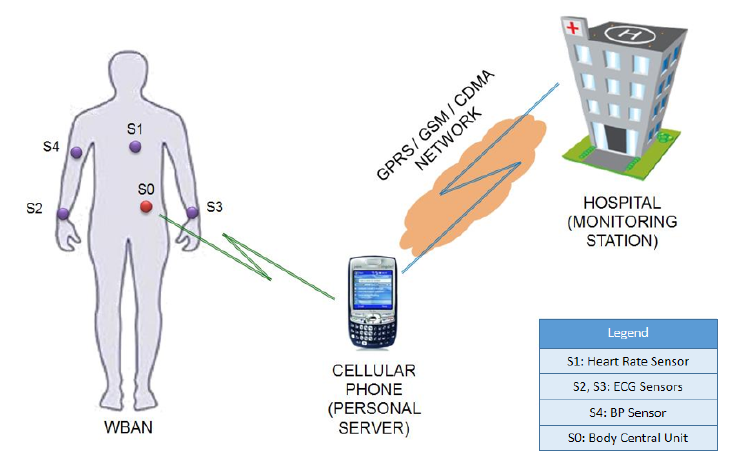
Figure 3. A Typical WBAN System